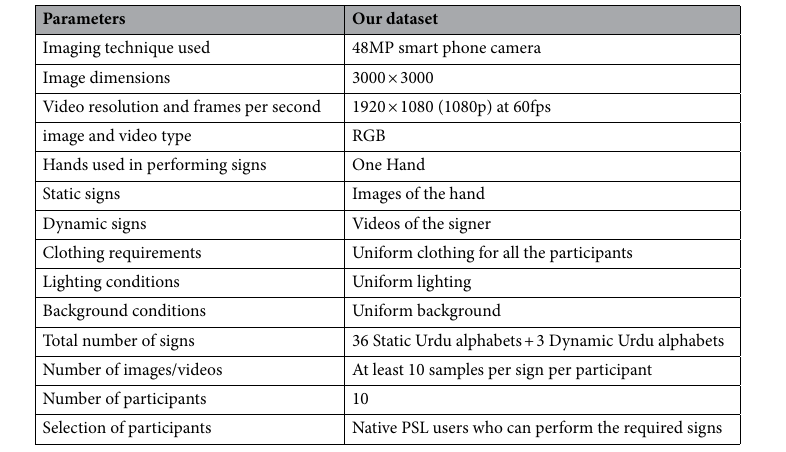
Table 1. PSL data collection